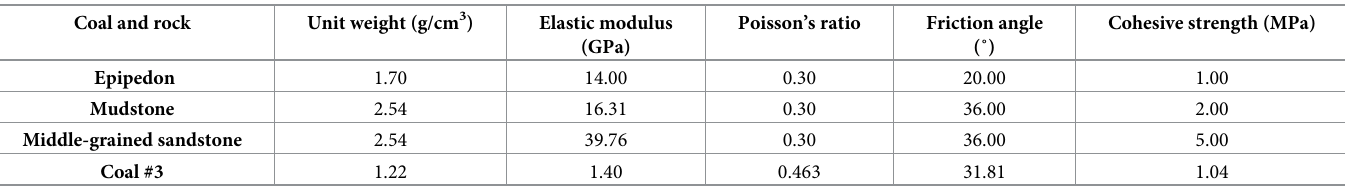
Table 2. Mechanical parameters of the collapse columns.